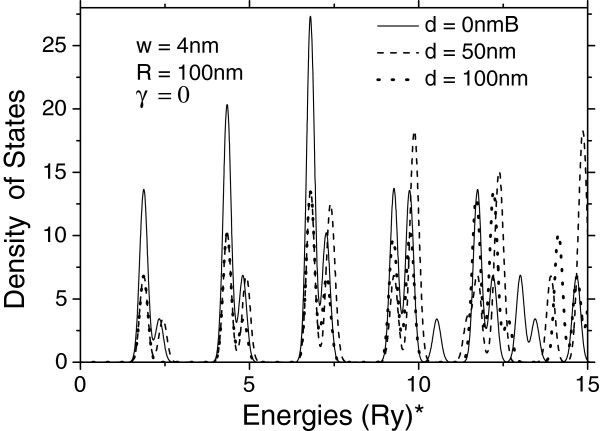
Density of states for three different distances between layers. Corresponding to low-lying levels of the double-donor complex in vertically coupled QDs.